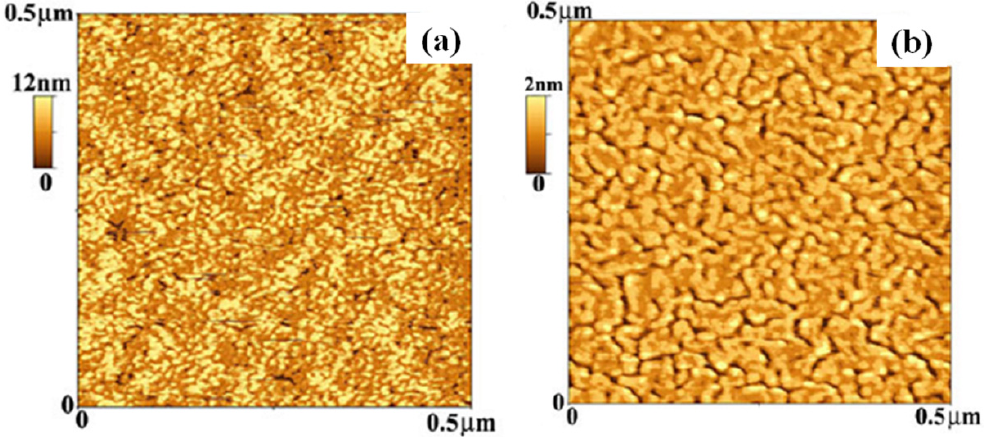
Figure 2. ( a , b ) AFM images of 10 nm-thick Au layer sputtered (at roomtemperature) onto 200 nm-thick polystyrene and poly(methyl methacrylate), respectively, spin-coated on Si. In ( c , d ) SEM images (200 nm by 120 nm) of 4 nm-thick Au evaporated (at room temperature) onto polyimide and poly(ethylene terephthalate), respectively. ((a,b): reproduced with permission from [21], Copyright Springer 2011; (c,d): reproduced with permission from [26], Copyright Elsevier 1997).